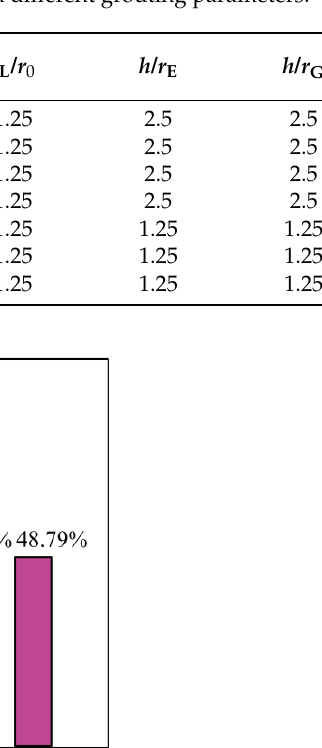
Table 7. Input data of computational analyses for Q G / Q with different grouting parameters.